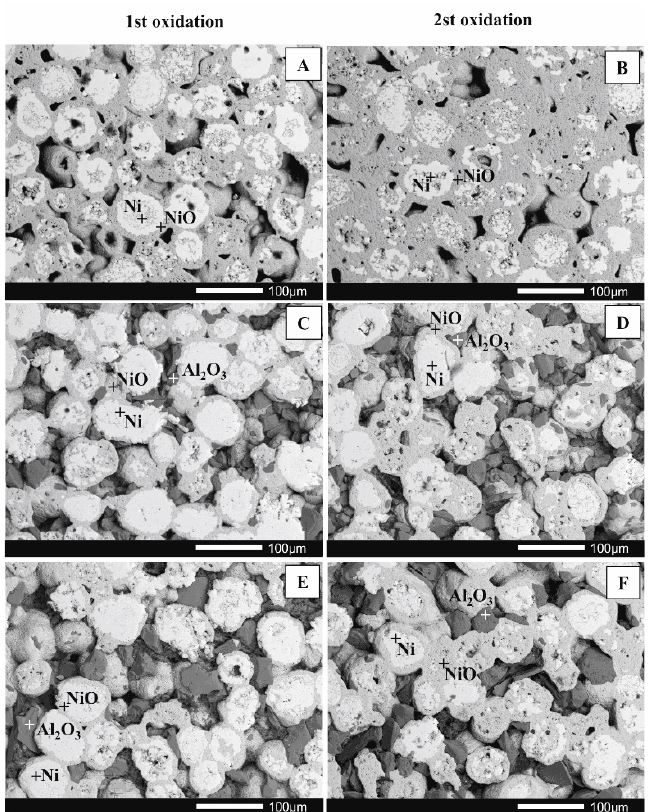
Figure 7. SEM images from the top region of the oxidized samples: Ni ( A , B ), Ni with Al 2 O 3 particles with a diameter of 5–20 μ m ( C , D ), and a sample of Ni with Al 2 O 3 particles with a diameter of 32–45 μ m ( E , F ). A, C, E after the first oxidation cycle; B, D, F after the second oxidation cycle.